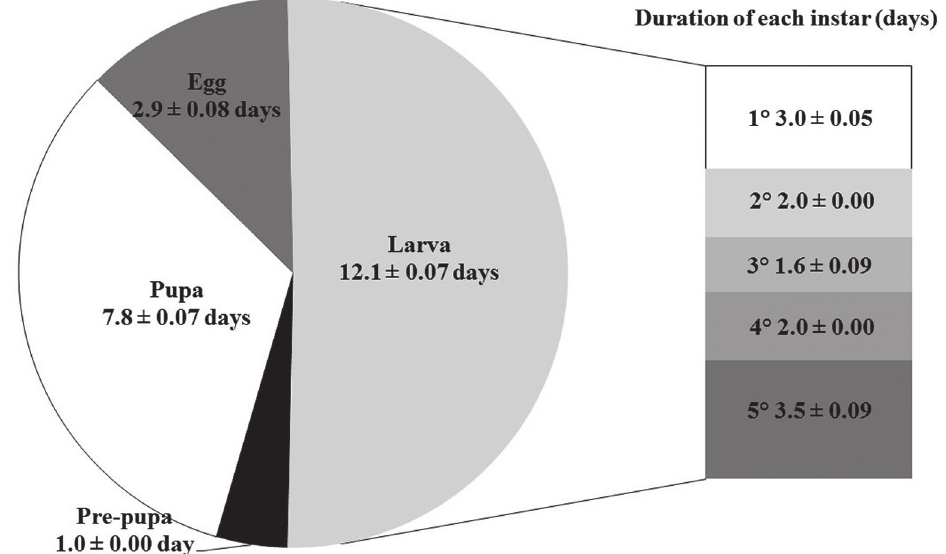
Figure 2 - Biological cycle for Condylorrhiza vestigialis (egg to adult, N=30) with the duration of each stage and the standard error of the mean, on Diet 3- corn, wheat germ and yeast-based. Temperature 25 ± 2°C, RH 60 ± 10% and photophase of 14 hours.